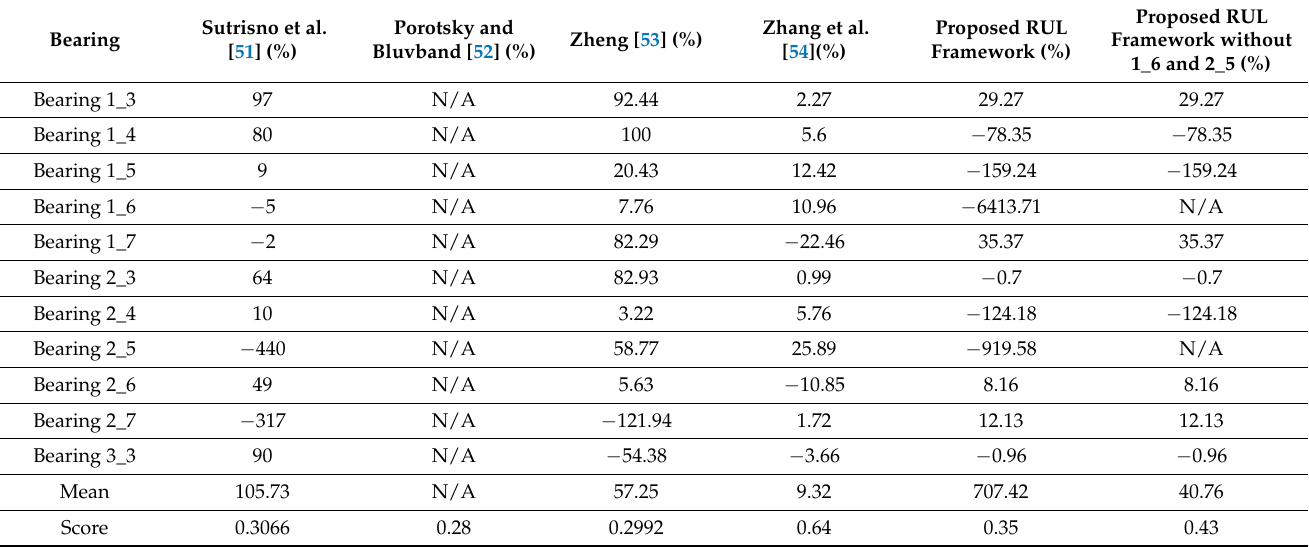
Table 4. This table shows the relative error (Er) , its mean, and the PHM score of the different RUL approaches and the proposed approach (with and without bearing datasets 1_6 and